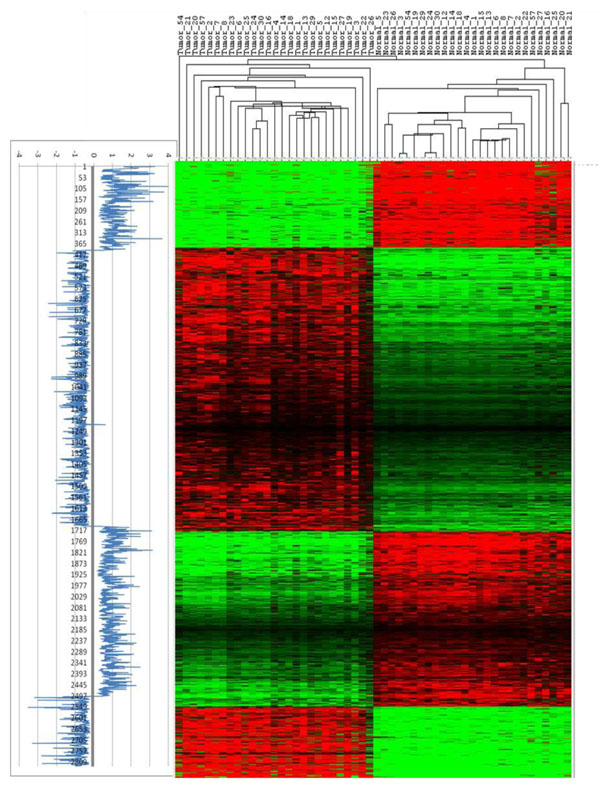
Heatmap depicting four gene clusters which perfectly separate the AC and the surround lung tissue samples. The similarity of the profiles was estimated using two-way hierarchical cluster analysis of the cross-normalized expression signal intensity values. The panel on the left of the heatmap shows the distribution of fold-changes of individual probe sets, ranked based on Euclidian distance metric. The distribution of the fold-change values specifies AC up- and down- regulated gene clusters.